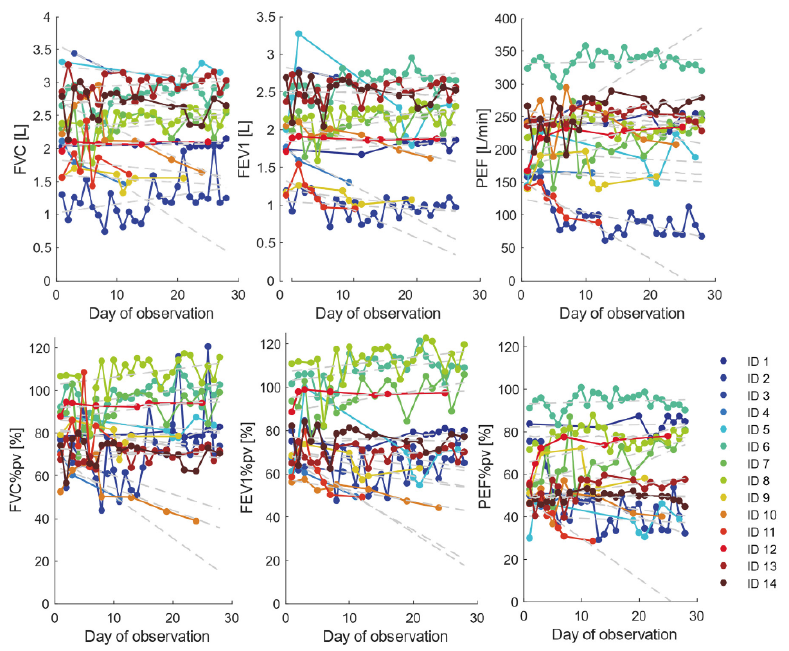
Figure 1. Pulmonary function test. Number of days of measurements of home spirometry for each individual patient. Participants measured pulmonary function for an average of 14 days with an average of 20 measurements during the study period. Of the 14 participants, 4 (28.5%) adhered to the requirement for using the device daily throughout the study (28 ± 3 days) and 2 (14%) took measurements on less than 10